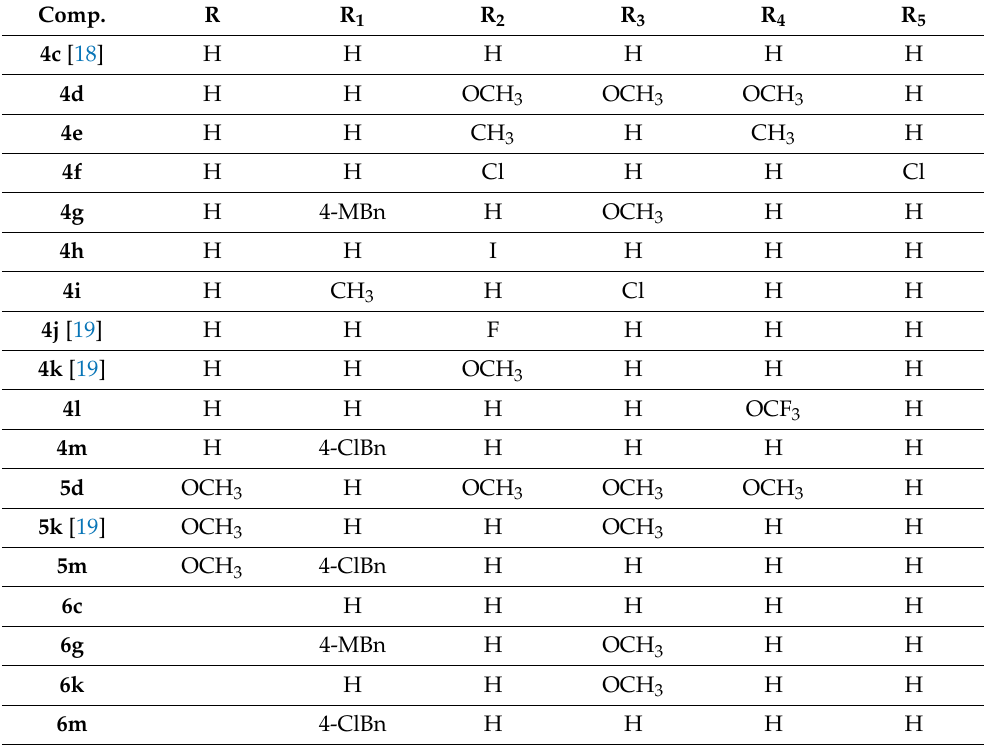
Table 1. New derivatives.